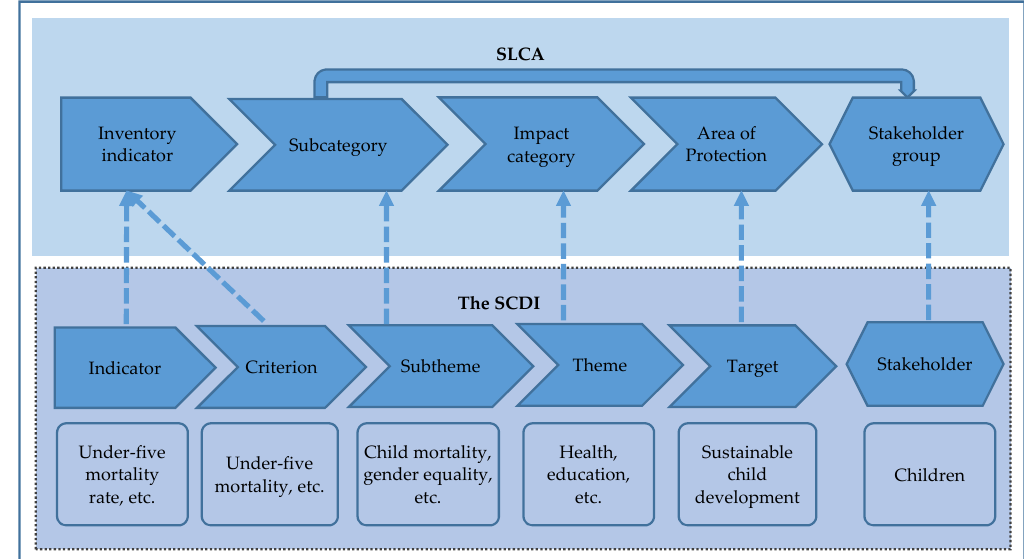
Figure 2. Scheme of SLCA and SOLCA (based on UNEP [9]) and an exemplary relation of the SCDI framework to SLCA and SOLCA.